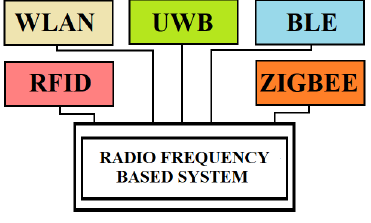
Figure 12. Radiofrequency-based systems.